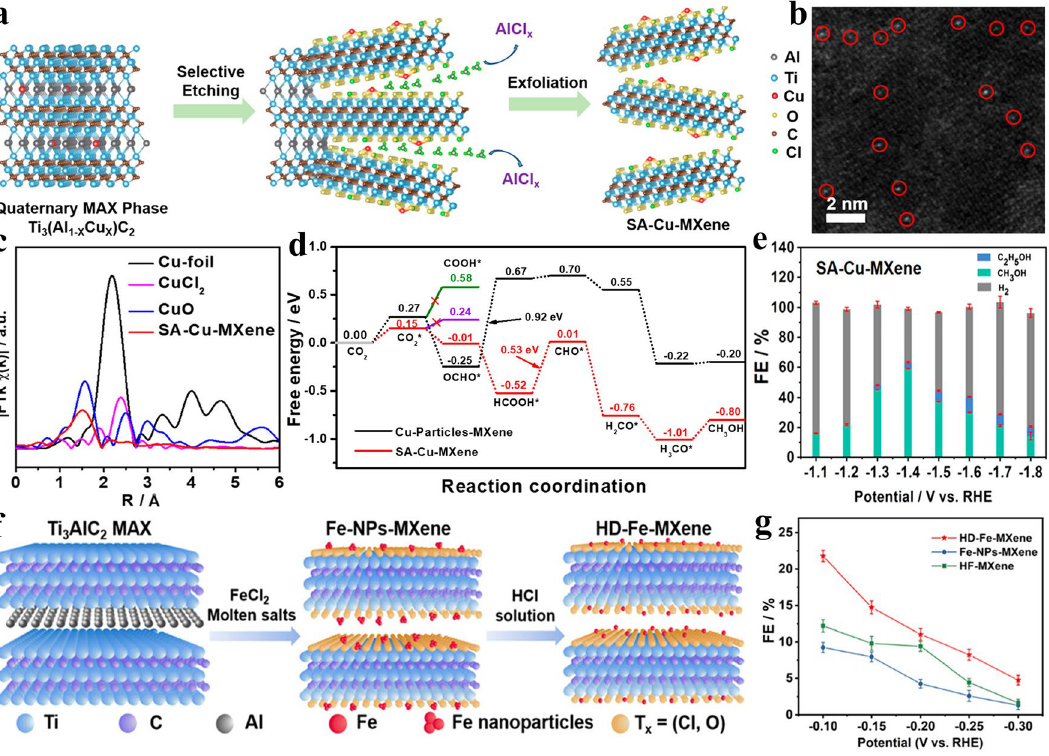
Fig. 16 a Schematic of the synthesis of SA-Cu-MXene. b HAADF-STEM image of SA-Cu-MXene. c XAS spectra of SA-Cu-MXene. d Free energy diagram of CO 2 to CH 3 OH. e Faradaic efficiency of SA-Cu-MXene at various potentials. Reproduced with permission from [158] Copy- right 2021, American Chemical Society. f Schematic of the preparation of HD-Fe-MXene. g Faradaic efficiency of different materials at